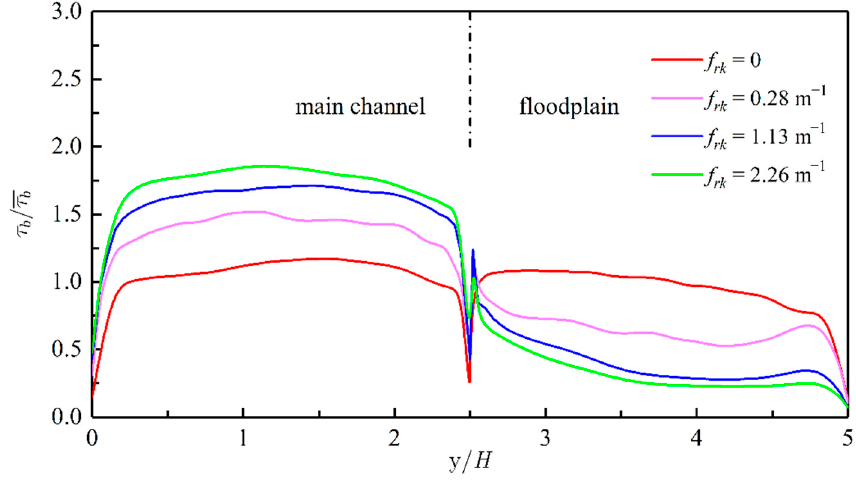
Figure 8. Bed shear stress with different floodplain vegetation densities.